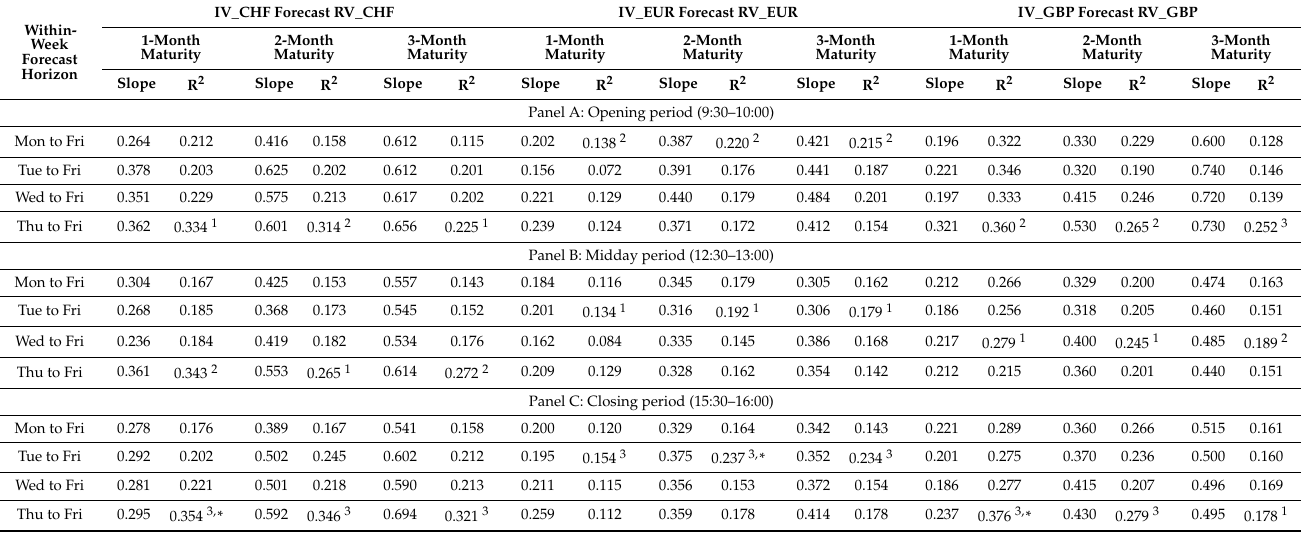
Table 1. IV forecast RV for within-week forecast